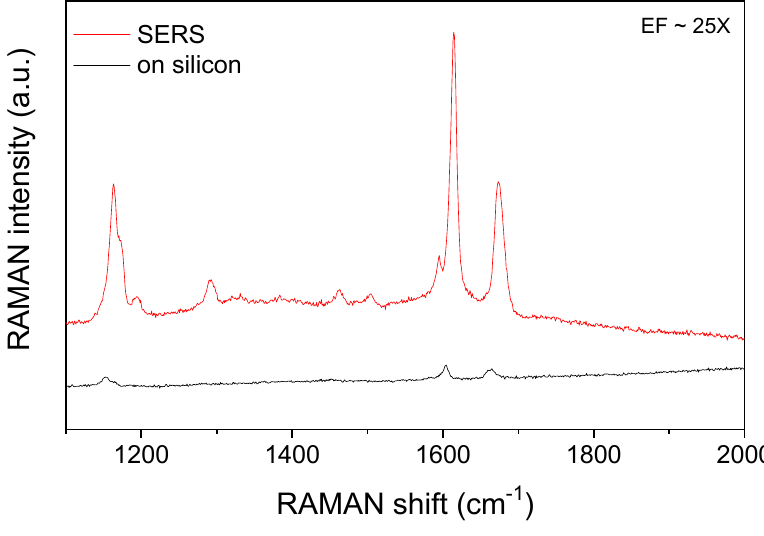
Figure 5. Comparison of the Raman signals of benzophenone detected on silicon, and on the periodic array of perforated pyramidal structures.